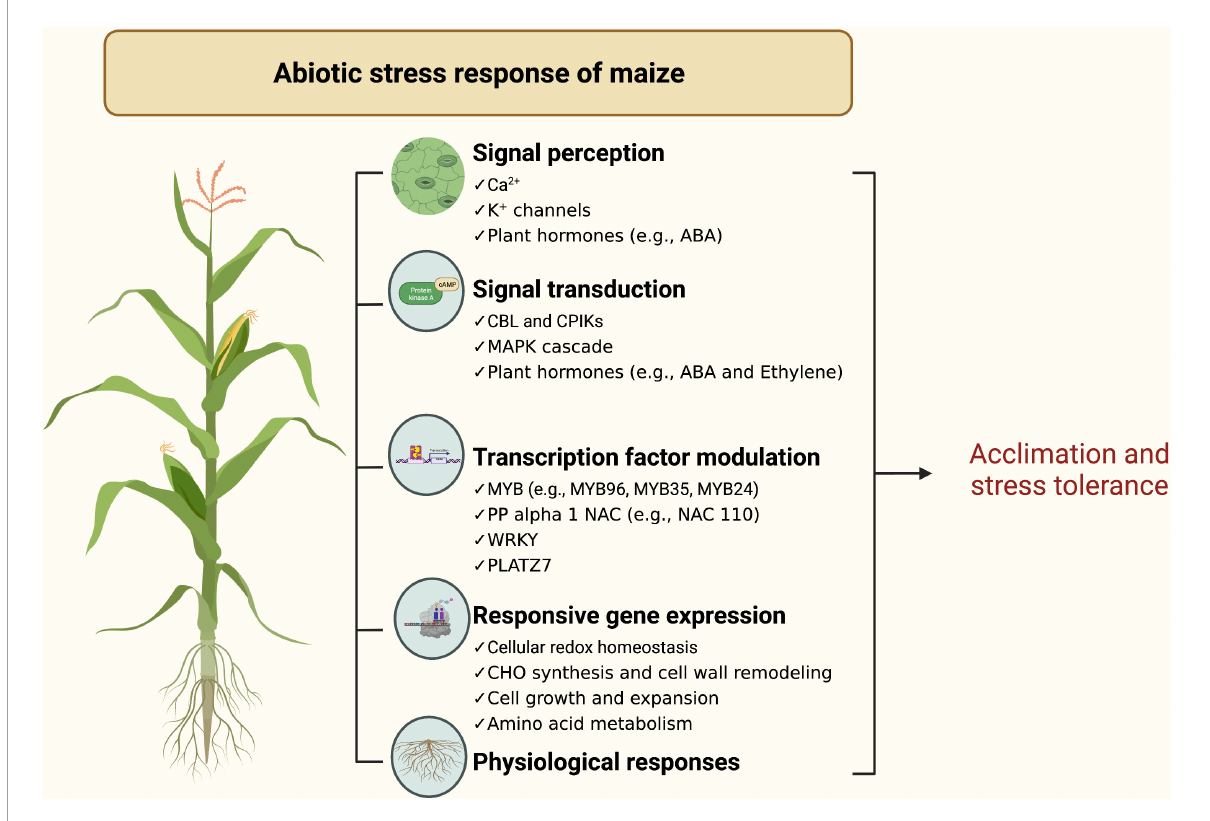
FIGURE3 Schematic diagram of maize physiological and genetic response to abiotic stress (https://biorender.com; accessed on 21 February 2022).